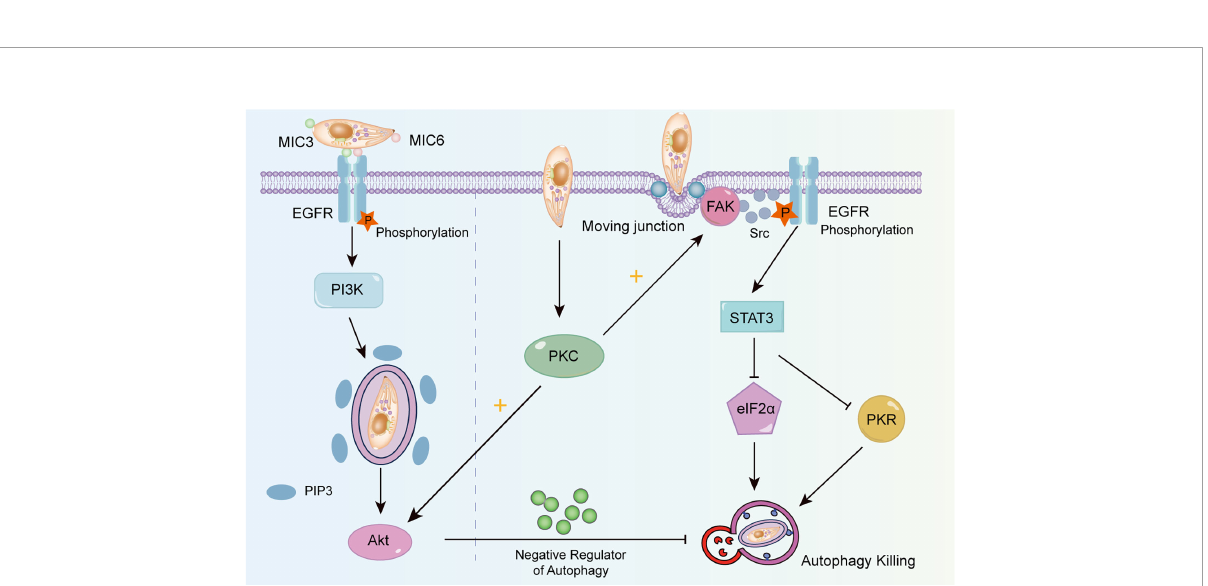
FIGURE 3 The mechanism of T. gondii changing autophagy targeting. T. gondii induces EGFR autophosphorylation through MIC3 and MIC6, triggers PI3K to produce PIP3, and then activates Akt to inhibit autophagy by producing negative regulators. The activation of FAK depends on the mobile connection formed when T. gondii invades. Activated FAK induces the transactivation of Src-dependent EGFR, and activates STAT3, thus suppressing PKR and eIF2 a signaling. T. gondii can also maintain the blockade of intracellular autophagy targets by activating PKC, which helps to maintain Src signaling, EGFR autophosphorylation and Akt activation.